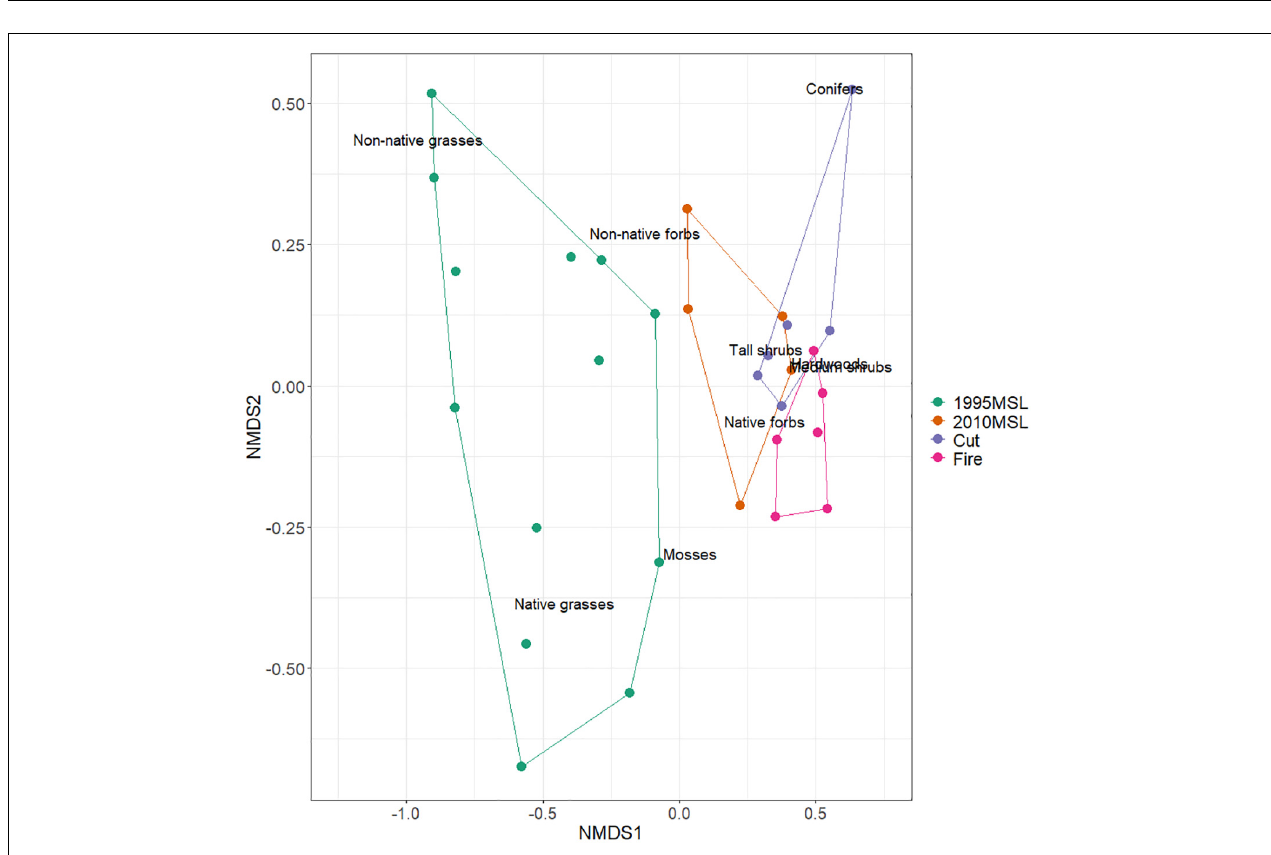
FIGURE 5 | Non-metric multidimensional scaling (NMDS) analysis of vegetation cover for the corresponding test sites. Ellipses constructed around each site indicate 95% confidence intervals.